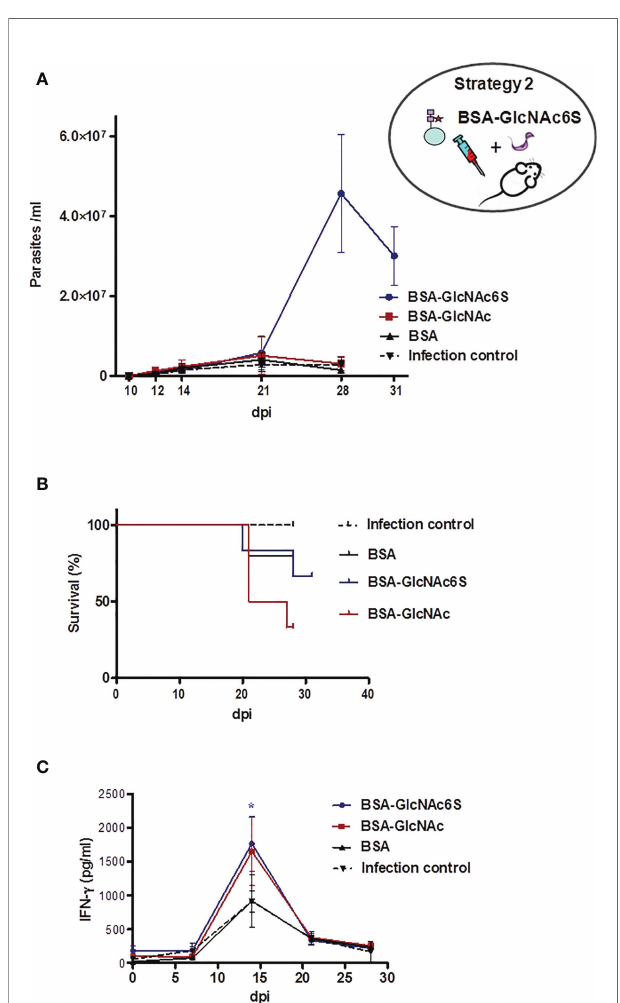
FIGURE 5 | BALB/c mice immunized with GlcNAc6S-BSA and sublethally challenged with T. cruzi . Parasitemia, survival, and INF- g levels during acute phase of sublethal infection from BALB/c mice, immunized with BSA-GlcNAc6S and BSA-GlcNAc, by T. cruzi using IFA as adjuvant. (A) Parasitemia (parasite number/ml of peripheral blood). (B) Survival percentage (%). Mice were subjected to a sublethal dose of 2,000 T. cruzi blood trypomastigotes, Tul 2 strain. In BSA-GlcNAc6S IM , parasitemia and mortality were monitored up to 31 dpi. (C) Production of INF- g in BSA-GlcNAc6S IM and BSA-GlcNAc IM . The serologic levels of IFN- g (pg/ml) were determined by capture ELISA, after sublethal infection of nonimmunized, BSA-GlcNAc6S IM , BSA-GlcNAc IM , and BSA IM in combination with IFA. The mean of each group determinations plus SD were calculated and graphed. Blue line, red line, black line, and dotted black line represent BSA-GlcNAc6S IM , BSA-GlcNAc IM , BSA IM , and control infection group, respectively. The oval scheme in the upper part of the fi gure represents strategy